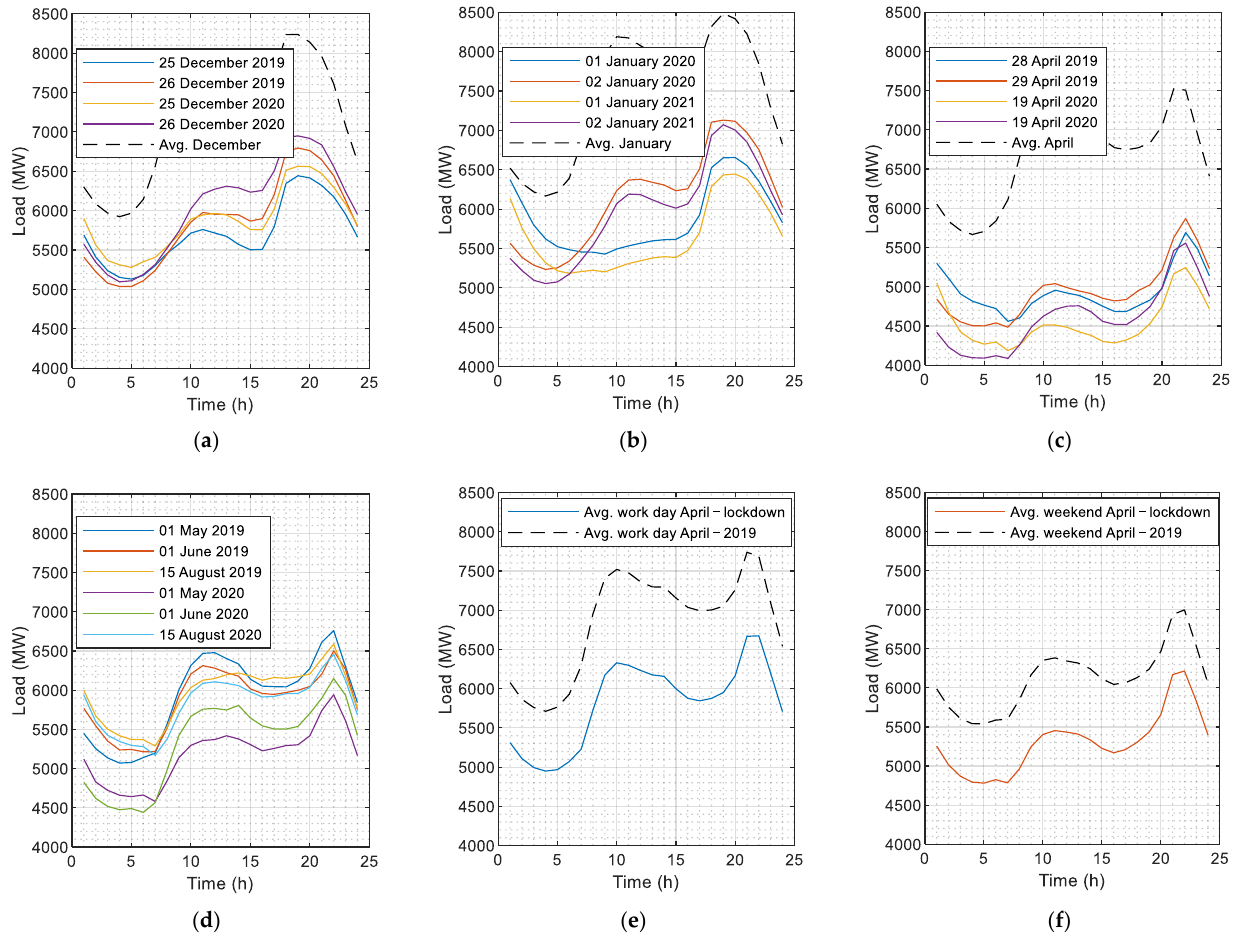
Figure 5. Load profile variation in Romania occurring on ( a ) Christmas; ( b ) New Year; ( c ) Easter; ( d ) Other legal holidays; ( e ) Workdays during lockdown; ( f ) Weekend days during lockdown.